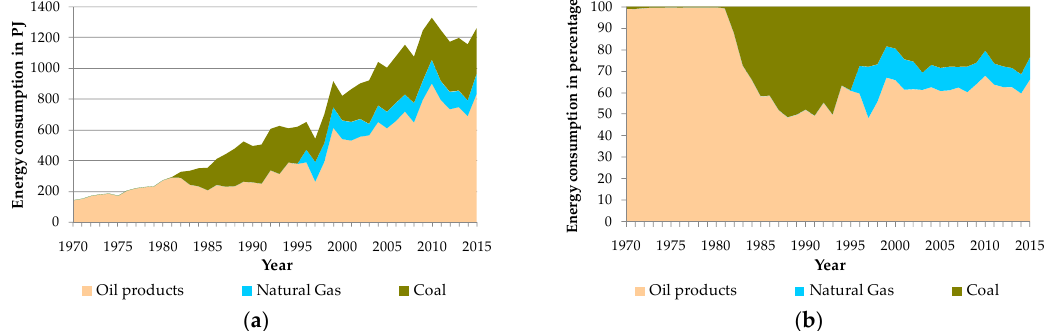
Figure 3. ( a ) Primary energy consumption in PJ for the period from 1970 to 2015 (yearly); ( b ) primary energy consumption in percentage for the period from 1970 to 2015 (yearly).